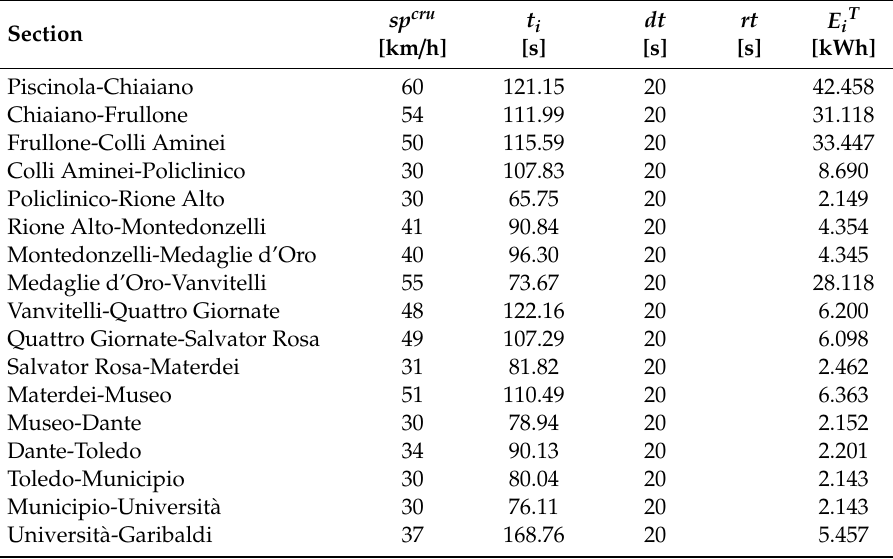
Table 4. Data after